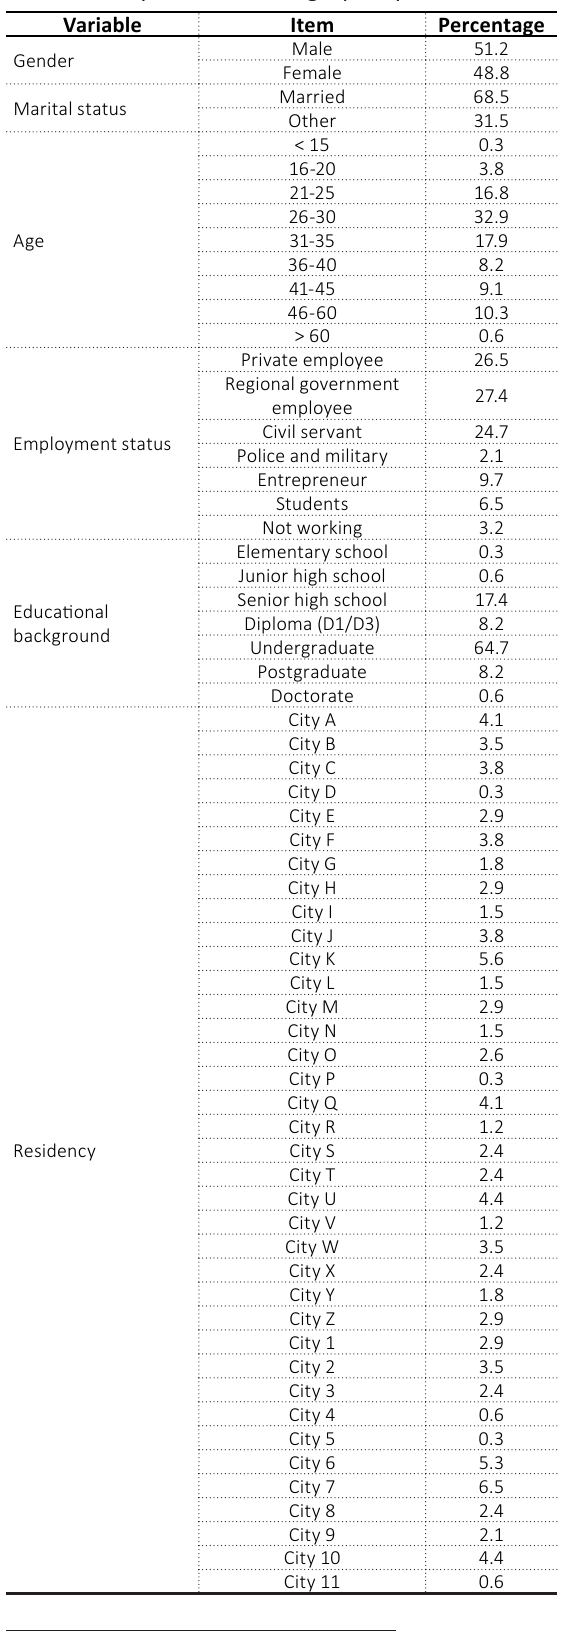
Table 2. Respondent demographic